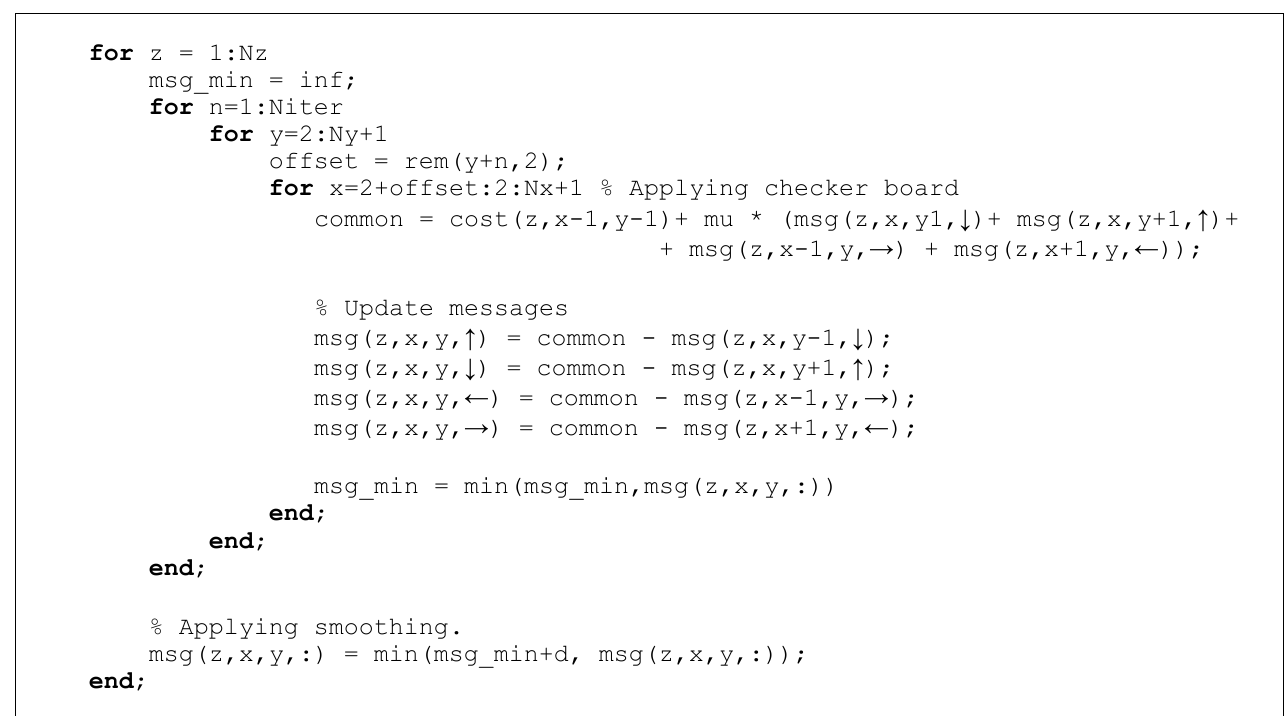
Table 1. Pseudo-code for the